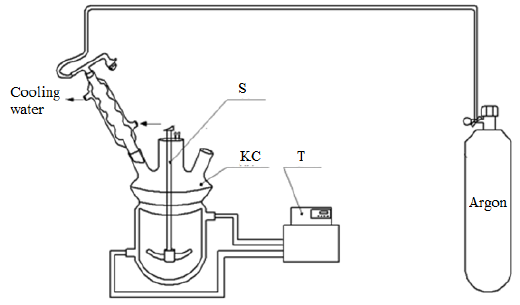
Figure 4. Reactor layout: KC—kinetic cell, S—stirrer, Т—thermostat.